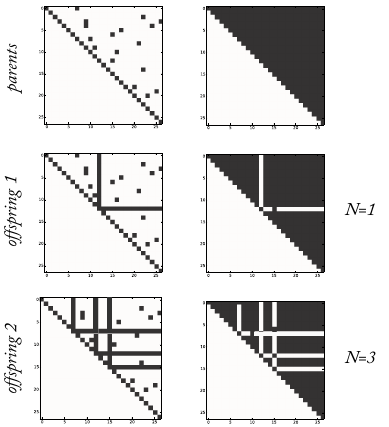
Figure 2. Topology crossover. In offspring 1, only the node location of one device terminal is exchanged. In offspring 2, three node locations are exchanged. For better illustration, the right parent is a full upper-triangular matrix